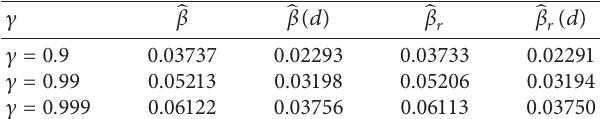
Table 4: The estimated MSE of the estimators when n �